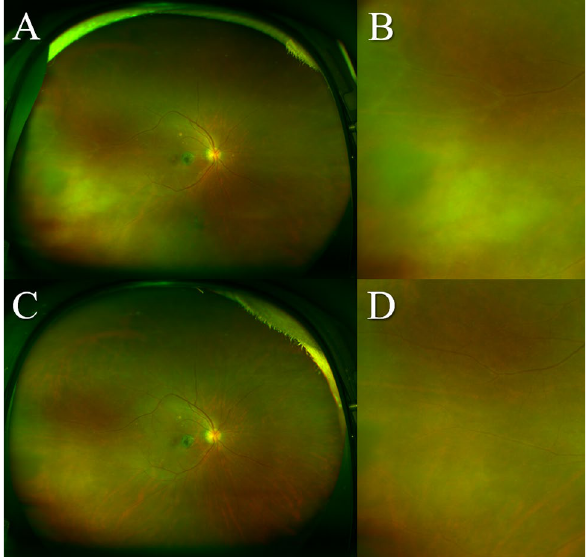
Figure 5. Fundus images of the right eye of a 77-year-old woman with polypoidal choroidal vasculopathy. She noticed floaters in her right eye approximately 3 weeks after the first injection of brolucizumab. Best-corrected visual acuity (BCVA) was 0.30 logarithm of the minimum angle of resolution (logMAR) units at 1 month after the first intravitreal brolucizumab injection. ( A ) Ultra-widefield color fundus imaging shows intraocular inflammation including vitritis and retinal vasculitis. ( B ) Magnified image of the temporal area of ( A ). Intravitreal brolucizumab therapy was stopped. She was promptly given combination therapy with subtenon injection of triamcinolone acetonide (30 mg/0.75 ml) and 0.1% betamethasone eye drops. BCVA of the right eye was improved to 0.10 logMAR units 1 month after the subtenon injection of triamcinolone acetonide. ( C ) Ultra- widefield color fundus imaging shows amelioration of the vitritis and retinal vasculitis. ( D ) Magnified image of the temporal area of ( C